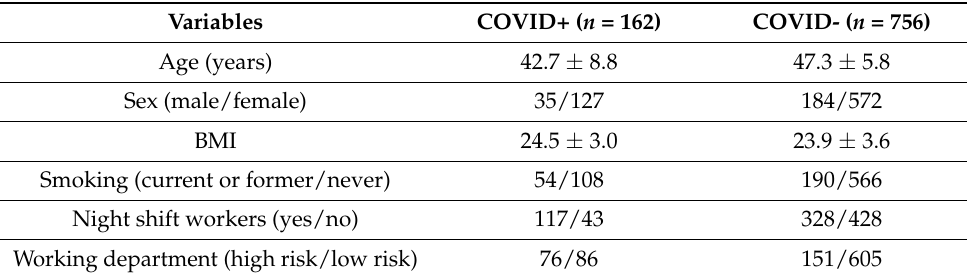
Table 1. Main population characteristic.